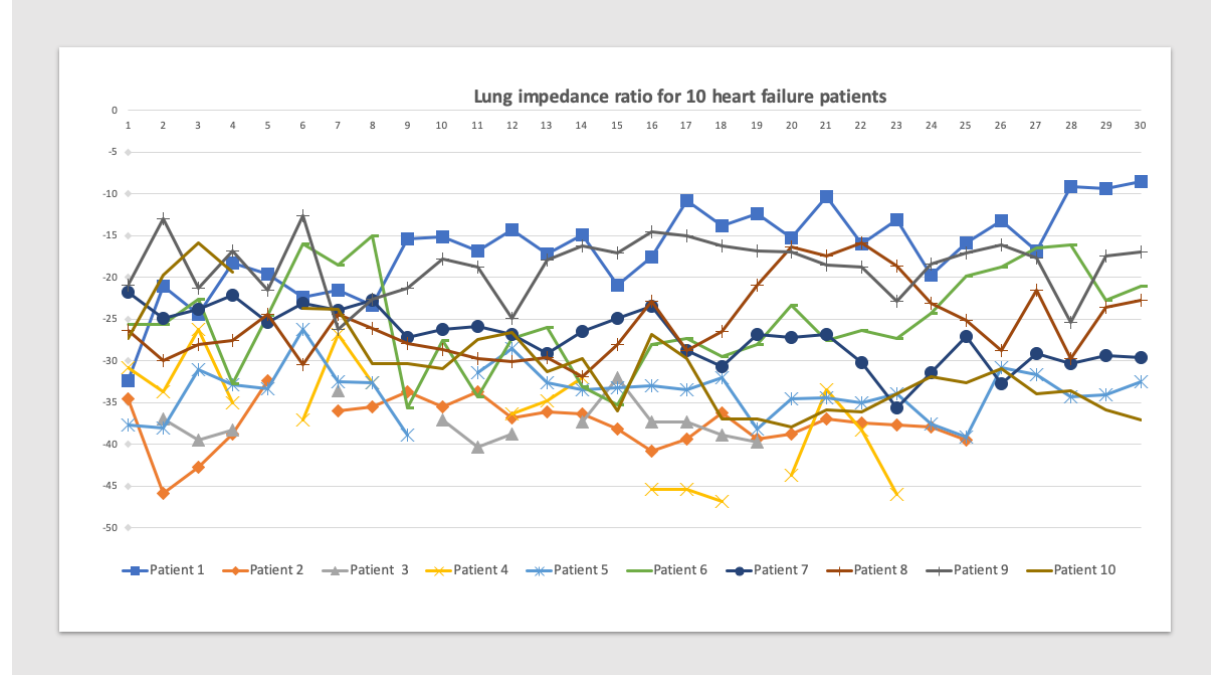
Figure 2. Individual lung impedance ratios ( Δ LIRs) during the 30-day postdischarge at-home assessment period. Each color or symbol represents the Δ LIR time series for 1 of the 10 participants. More negative Δ LIRs translate to more pulmonary congestion. Missing data (interrupted time series) resulted from a poor electrode connection, an intervening hospitalization, or a participant temporarily lacking help from their home caregiver to perform measurements. An Edema Guard Monitor (CardioSet Medical) lung impedance device was used to measure lung impedance (see the Methods section for calculation of Δ